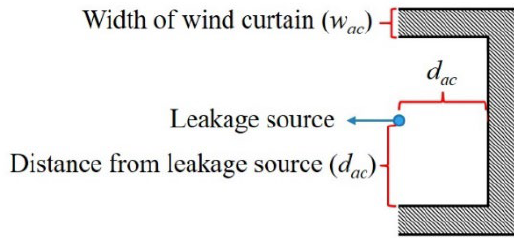
Figure 10. Schematic diagram of air curtain.